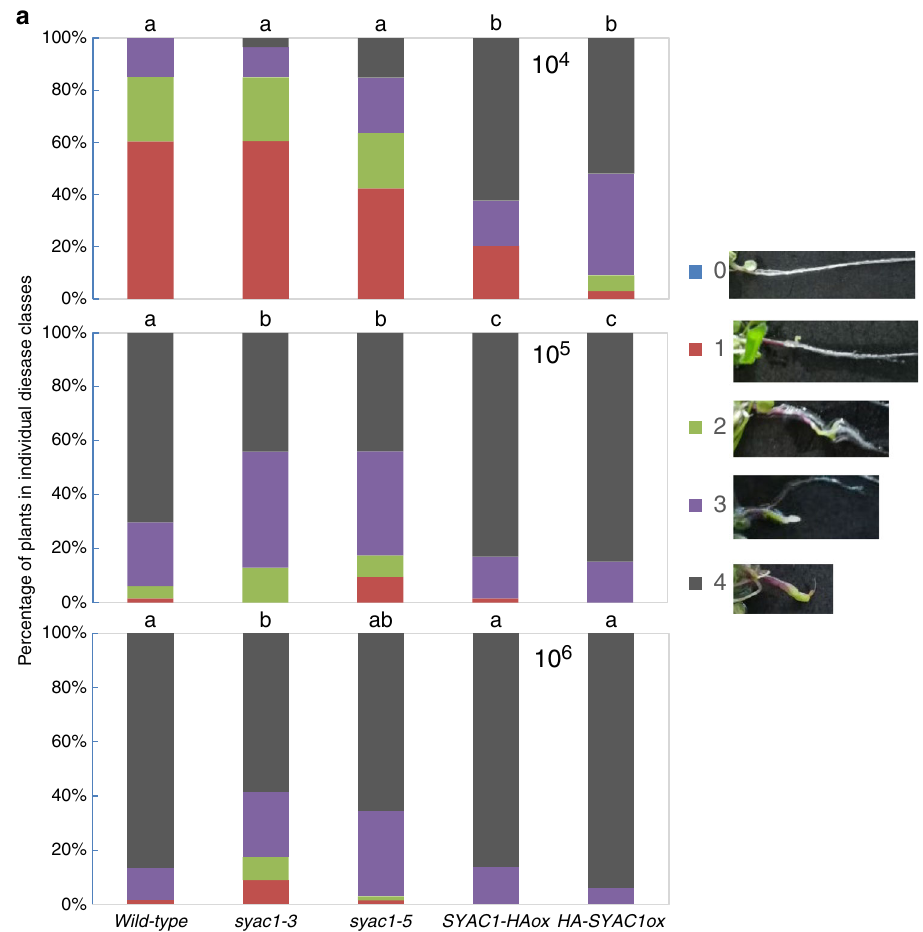
Fig. 6 Loss of SYAC1 activity increases tolerance to Plasmodiophora brassicae infection. a syac1-3 and syac1-5 mutant alleles exhibit reduced sensitivity to fungal infection when compared with wild-type control. In contrast, the overexpression of SYAC1ox results in oversensitivity to the pathogen. Five-scale classi fi cation was used to evaluate disease severity: 0 (no symptoms), 1 (very small galls mainly on lateral roots and that do not impair the main root), 2 (small galls covering the main root and few lateral roots), 3 (medium to large galls, also including the main root; plant growth might be impaired), and 4 (severe galls on lateral root, main root, or rosette; fi ne roots completely destroyed; plant growth is reduced). Inoculation was performed with 10 4 , 10 5 , and 10 6 spore concentration. Signi fi cant differences between datasets are indicated by different letters. Data were statistically analyzed using the Kruskal – Wallis